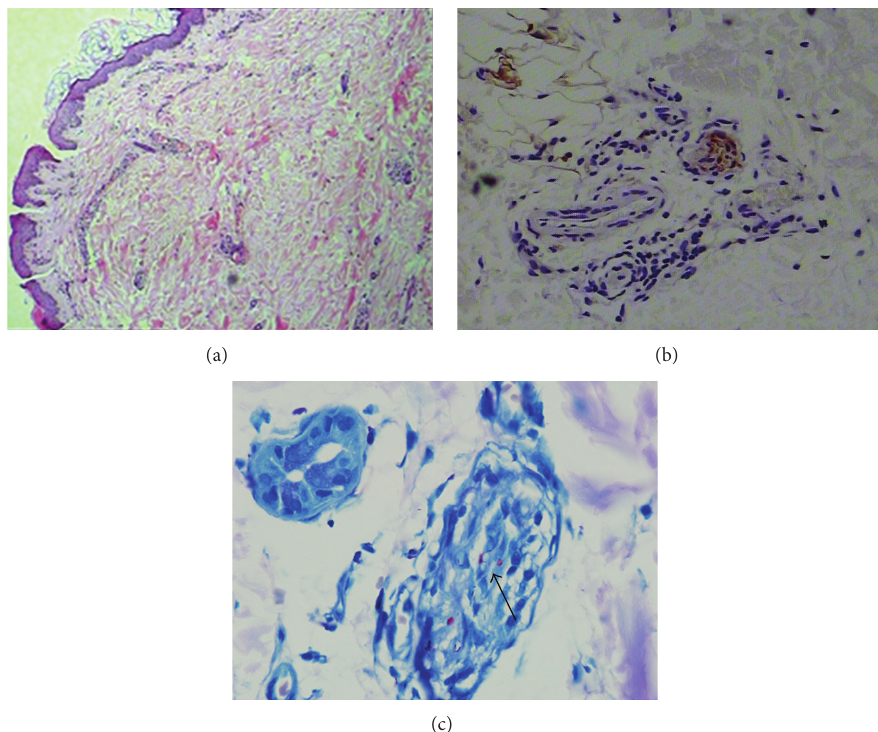
F 3: Microscopic presentation of leprosy in household contact C13. In (a), hematoxylin and eosin staining at 200 magni�cation revealed epidermal atrophy, vascular dilation, and lymphocytic in�ltration in neurovascular bundle. In (b), S-100 protein staining of a dermal nerve cross-section revealed perineural and perivascular in�ltration (at 400 magni�cation). In (c), single AFB in perineurium and × aggregated AFB in fascicle could be observed at 1000 × ×